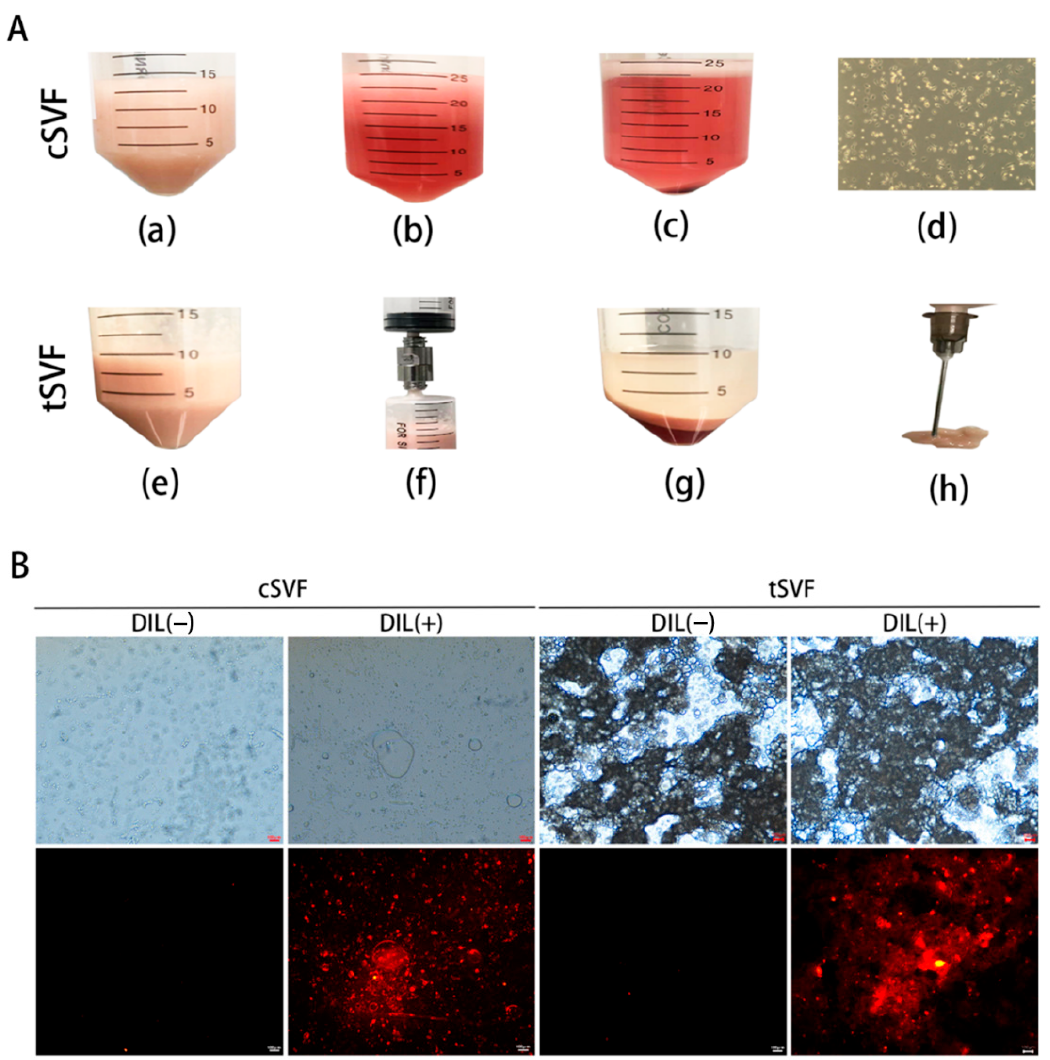
Figure 1. ( A ) Extraction process of cSVF (first row) and tSVF (second row). ( a , e ) Sheared fat particles; ( b ) adipose tissue after neutralization and digestion using DMEM complete medium; ( c ) centrifuged mixture; ( d ) cell morphology of cSVF in culture, after the first medium change; ( f ) fat passed through tSVF converter; ( g ) centrifuged emulsified celiac mixture; ( h ) 27 g needle injection of tSVF. ( B ) cSVF and tSVF with DIL markers. Left: cSVF on the left; Right: tSVF. First row: images under phase contrast microscope; Second row: images under fluorescent channel.